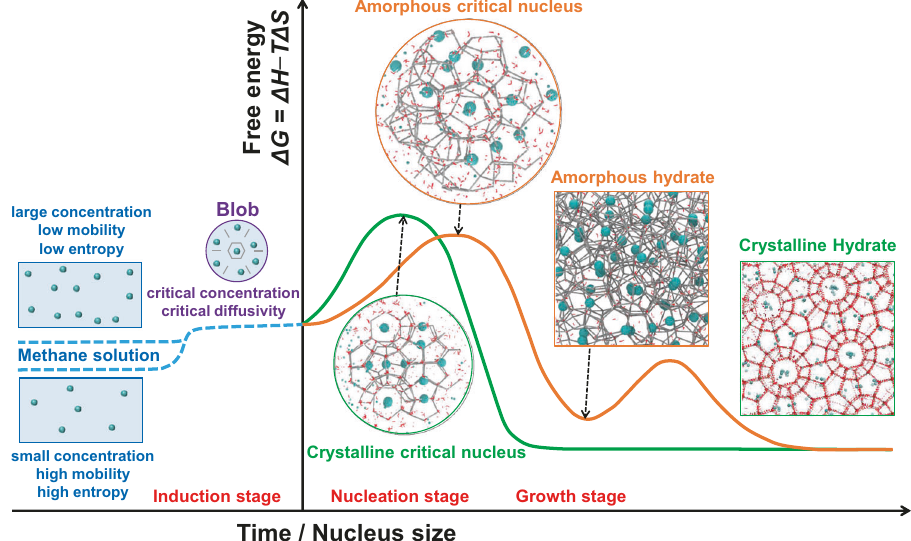
Fig. 1 Schematic diagram showing methane hydrate nucleation. In the induction stage, increasing methane concentration will slow down molecular mobility, reduce system entropy, and increase free energy. When the critical concentration is reached in a local region near the gas – water interface, a blob forms with methane separated by water. At such high concentrations, water cages occur with a very large probability. Then, water cages adsorb surrounding methane molecules so as to concentrate the methane again. This process is spontaneous, and the adsorption interaction helps the blob to overcome energy barriers with forming a critical hydrate nucleus (i.e., cage clusters). Because the types of the fi rst cage and the linking pattern of the subsequent cage clusters are uncertain, the critical nucleus ’ structure is stochastic, leading to multiple pathways: directly forming the crystalline hydrate and indirectly forming the amorphous hydrate followed by an annealing/ripening process to ultimately reach the crystalline